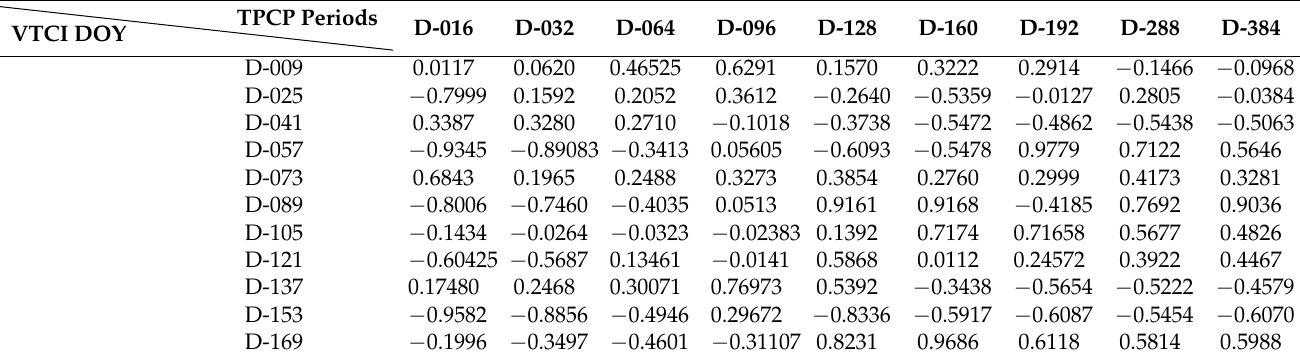
Table 4. Linear correlation coefficient between cumulative anomaly precipitation (departure from normal monthly precipitation, DPNP) and VTCI, for the first sixteen days of January (D-009) to the first sixteen days of June (D-169), for the twelve years 2003–2014, with cumulative precipitation TPCP at certain periods Pi, from sixteen days (D-016) to one year (D-384) during